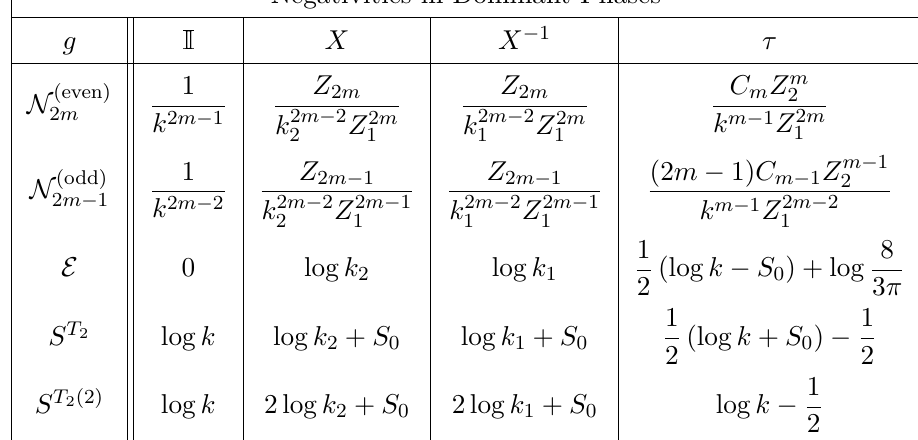
(cid:0) 2 m (cid:1) is the Catalan number m +1 m